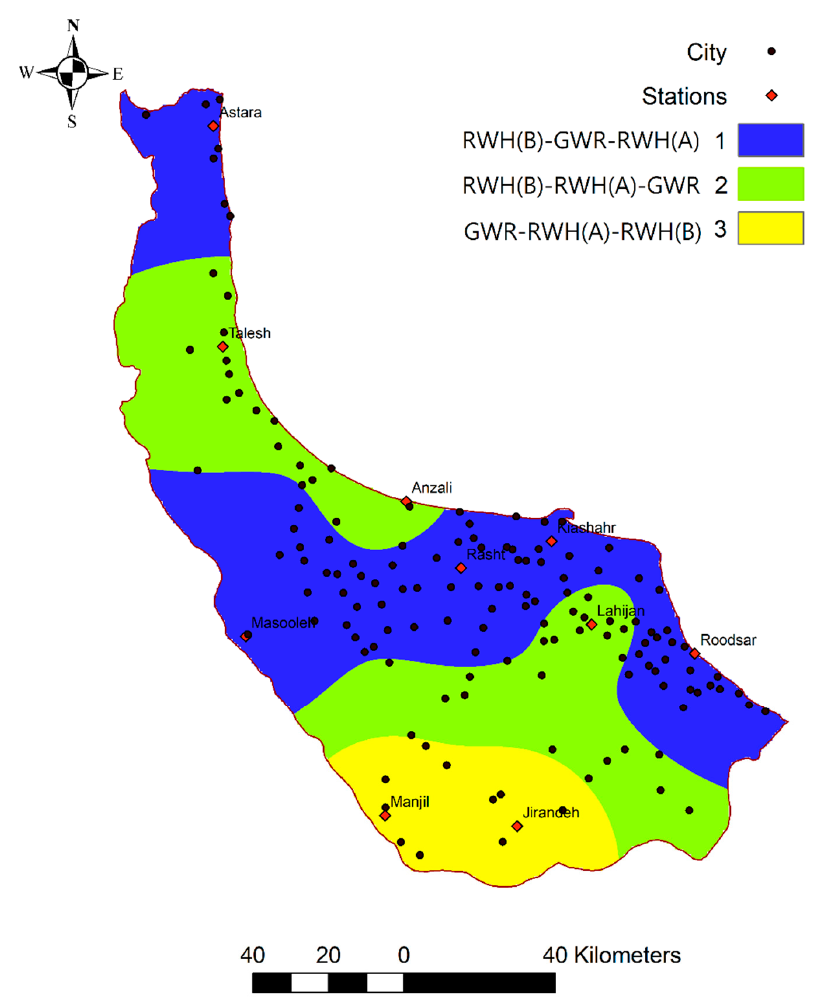
Figure 11. Distribution of water-saving plans based on MCDM.